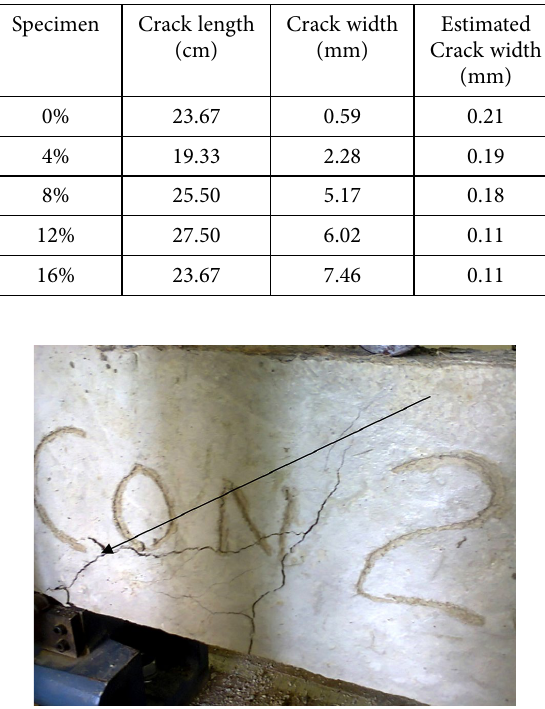
Fig. 8. Shear cracks in control beam (0% mix)